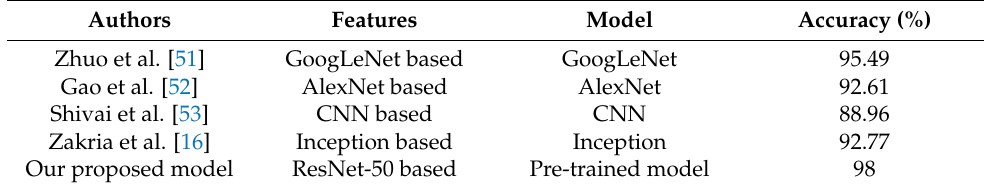
Table 5. A comparison of the proposed approach to existing vehicle